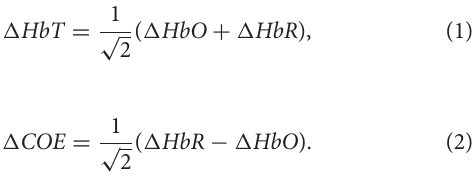
HbO and HbR) in the 1 HbO- 1 HbR phase diagram. An